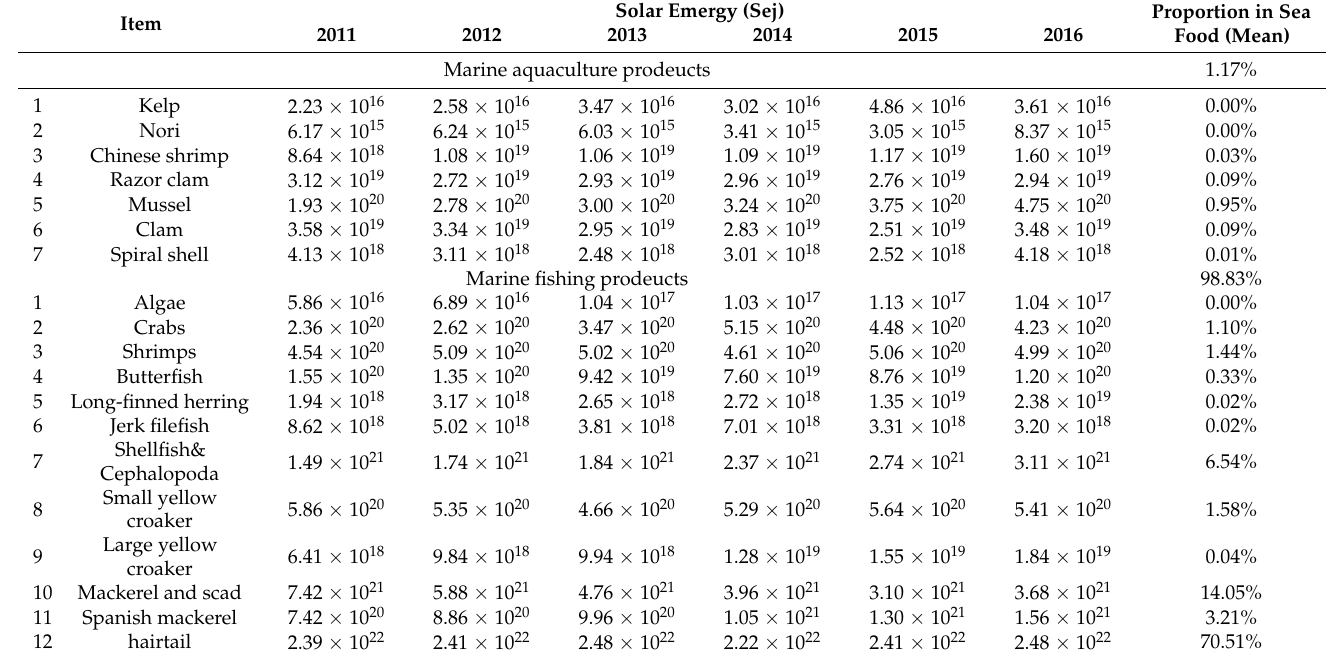
Table 4. The emergy flows of sea food in Zhoushan sea area